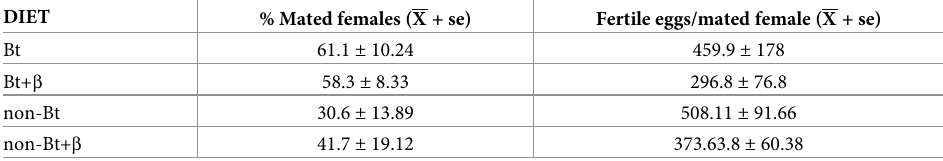
Table 2. Mating and fertility of Helicoverpa armigera F1 females.